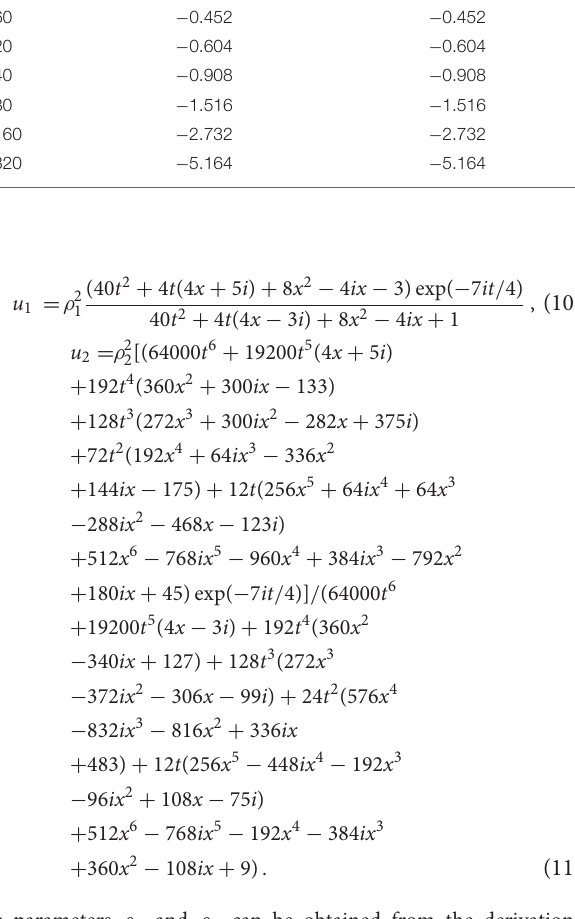
TABLE 1 | Correlating the real parts of the poles in the complex x plane and locations of maximum heights in physical space. Value of Maximum of | A | Turning points of trajectories parameter b in physical of imaginary parts in space